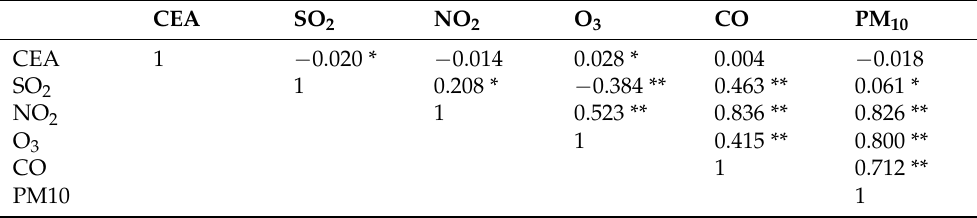
Table 4. Pearson correlation of carcinoembryonic antigen (CEA) and air pollutants. CEA SO 2 NO 2 O 3 CO